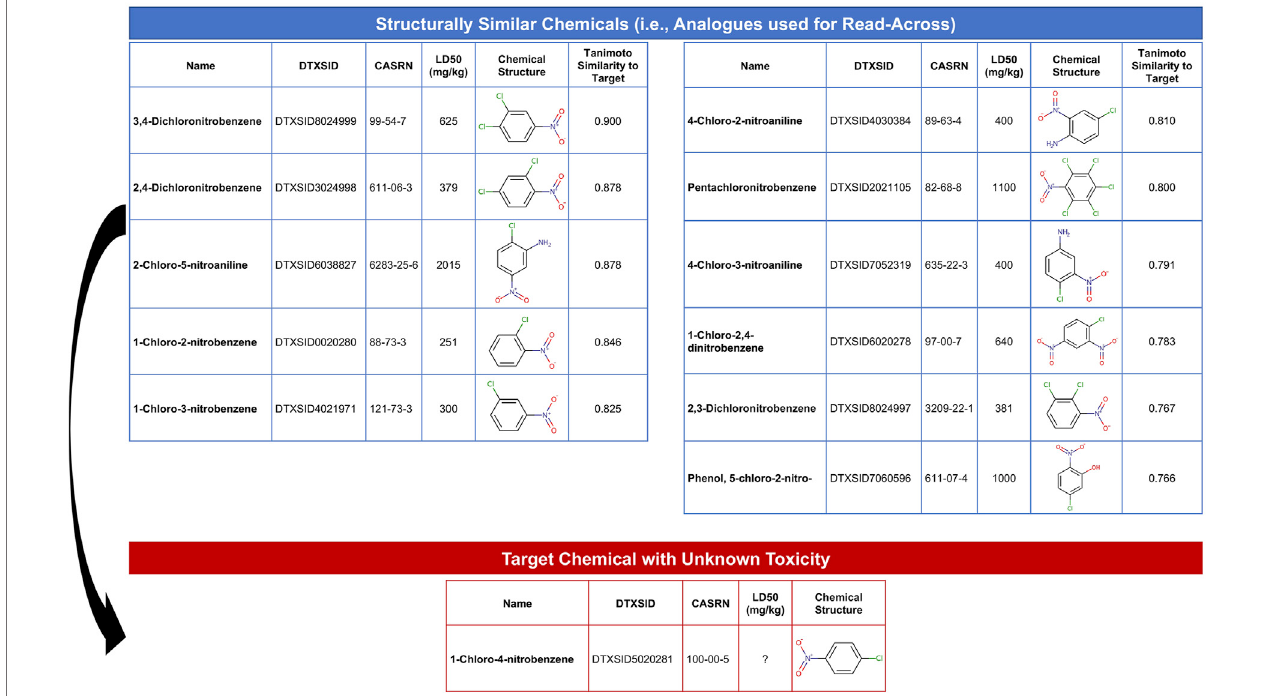
FIGURE 8 | Overall schematic summarizing the steps employed in this example read-across analysis to predict chemical toxicity. This training module guides traineesthroughthegenerationofchemicalstructure fi ngerprintdataanduseofthesedatatoidentifyanaloguesthatcanbeusedtopredicttoxicityforchemicalslacking data. This example uses chemicals with acute toxicity data (LD 50 values) to predict an example target chemical ’ s acute toxicity that is structurally similar.